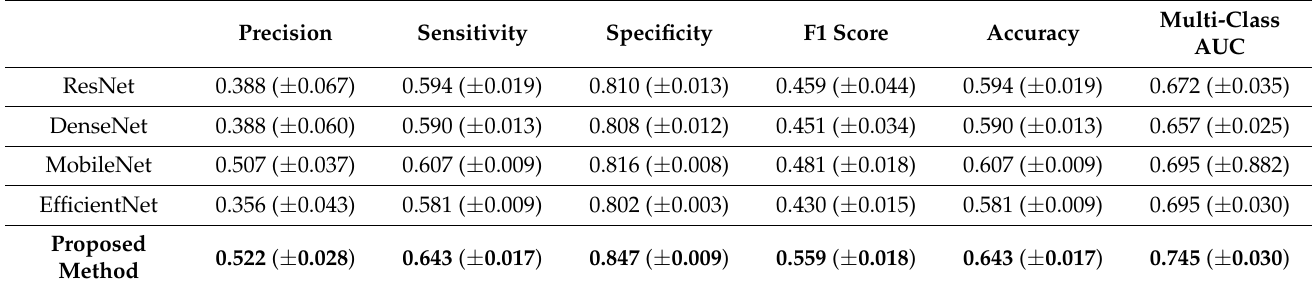
Table 1. Performance of various methods on overall distribution classification.